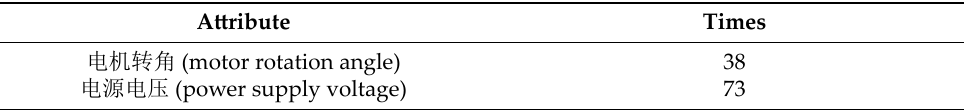
Table 7. The times of occurrences of each